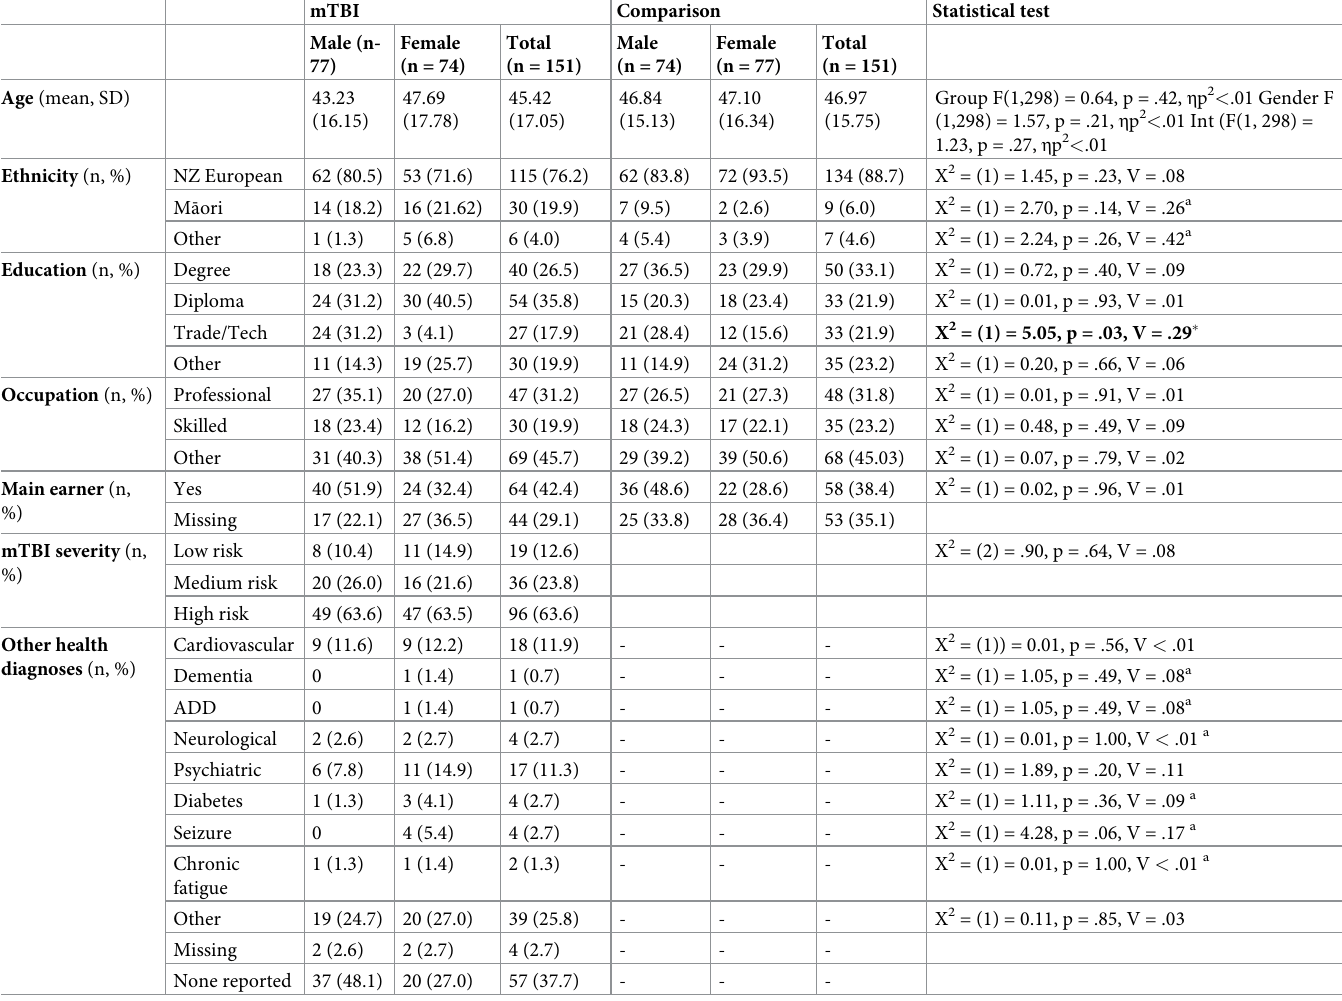
Table 2. A comparison of the demographic characteristics of the males and females in the mTBI group 8 years post-injury and the comparison group. Data are pre- sented as mean (standard deviation) or number (percentage) for demographic variables for the mTBI and comparison group and for injury severity and medical diagnoses for the mTBI group (information not available for the comparison group). Two-way ANOVA or chi-square tests were used to explore differences by group and